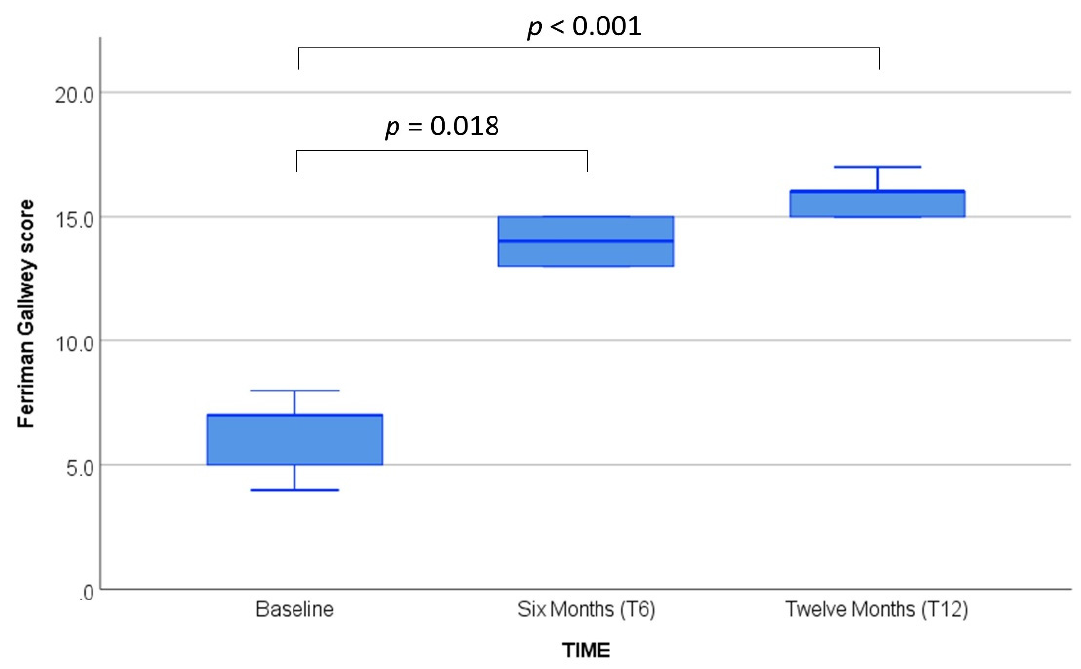
Figure 2. Ferriman–Gallwey score at baseline and after gender assignment hormone therapy (T6 and T12). Friedman’s test. p -values are Bonferroni adjusted.